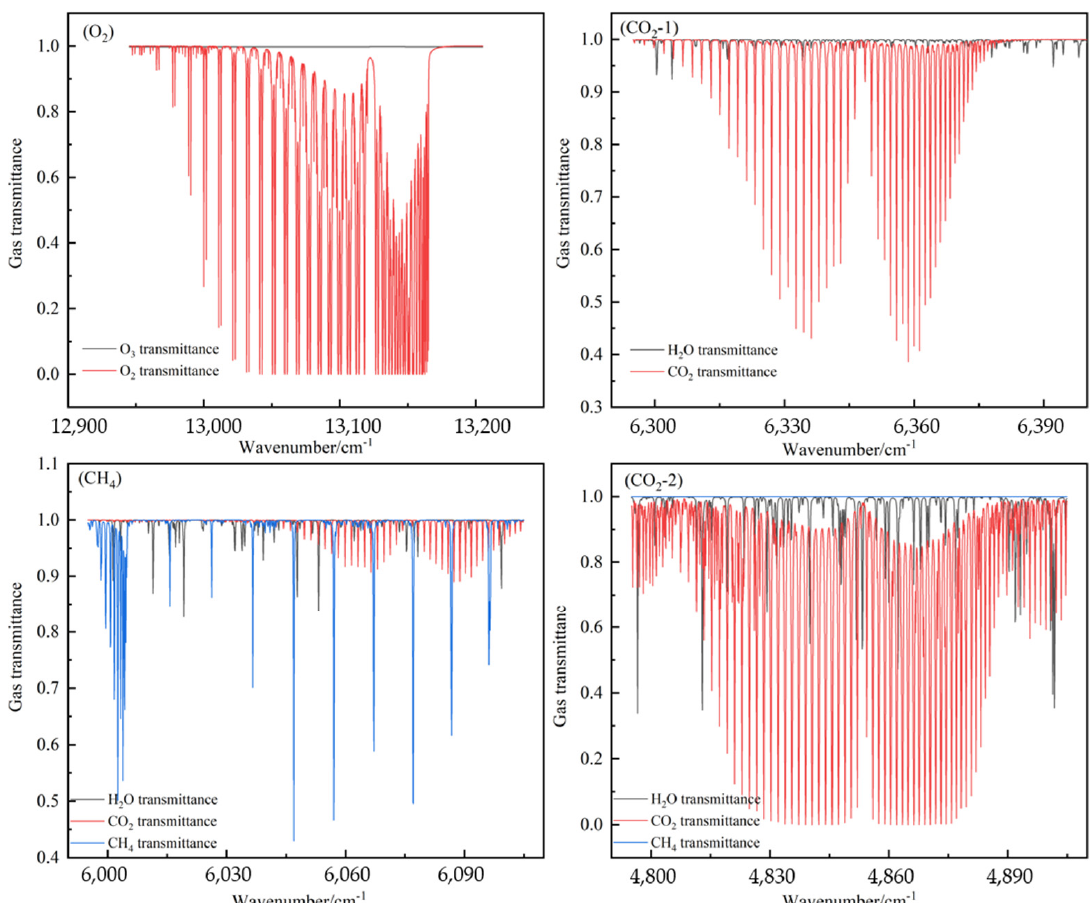
Figure 18. Main gas permeability of the four GMI channels.